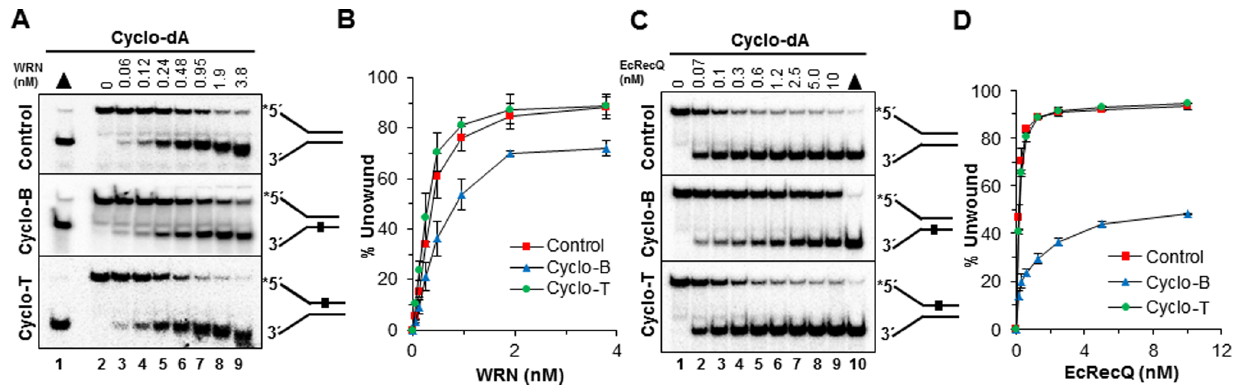
Figure 3. Effect of a site- and strand-specific cyclopurine lesion on WRN or EcRecQ helicase activity. Helicase reactions of 20 m l were carried out by incubating the appropriate WRN or EcRecQ concentrations with 0.5 nM forked duplex DNA that contained a cyclopurine lesion in the top strand (nontranslocating-Cyclo T), bottom strand (translocating-Cyclo B), or neither strand (Control) at 37 u C for 15 min under standard helicase assay conditions described in the Materials and Methods. A, WRN unwinding of undamaged and cyclo dA damaged DNA substrates. lane 1, heat denatured DNA substrate control, lane 2 no enzyme control, lane 3–9, indicated concentrations of WRN. B, Quantification of WRN helicase activity on cdA substrates with error bars. C, EcRecQ unwinding of undamaged and cyclo dA damaged DNA substrates. Lane 1, no enzyme control; lanes 2–9, indicated concentrations of EcRecQ; lane 10, heat-denatured DNA substrate control. D, Quantification of EcRecQ helicase activity on cdA substrates with error bars.